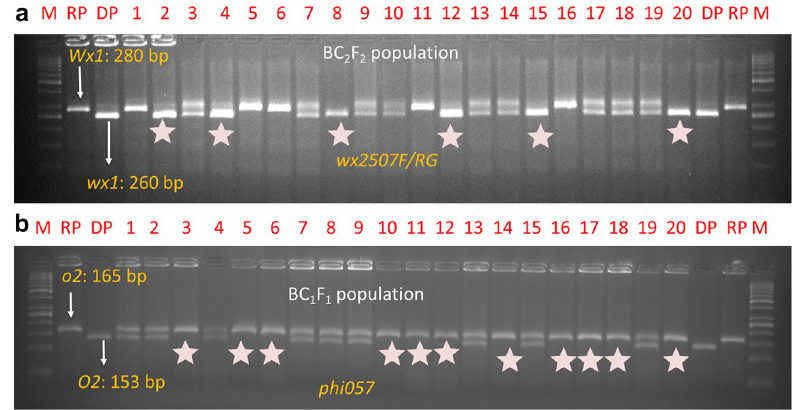
Figure 2. ( A ) Foreground selection for wx1 gene in BC 2 F 2 generation. DP: donor parent, RP: recurrent parent, M: Ladder 50 bp, Star indicates homozygotes recessive, ( B ) Foreground selection for o2 gene in BC 1 F 1